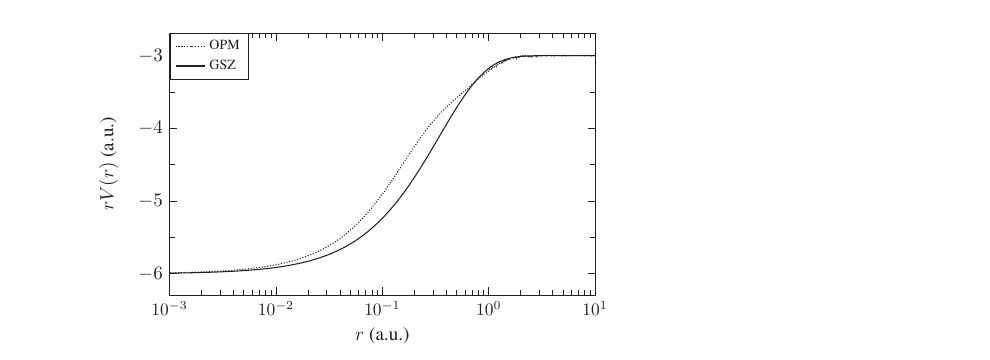
Figure 3. Distance-weighted effective potential of the C 3 + projectile as a function of radial distance. Potentials calculated using the OPM [15] and GSZ [17] are displayed.